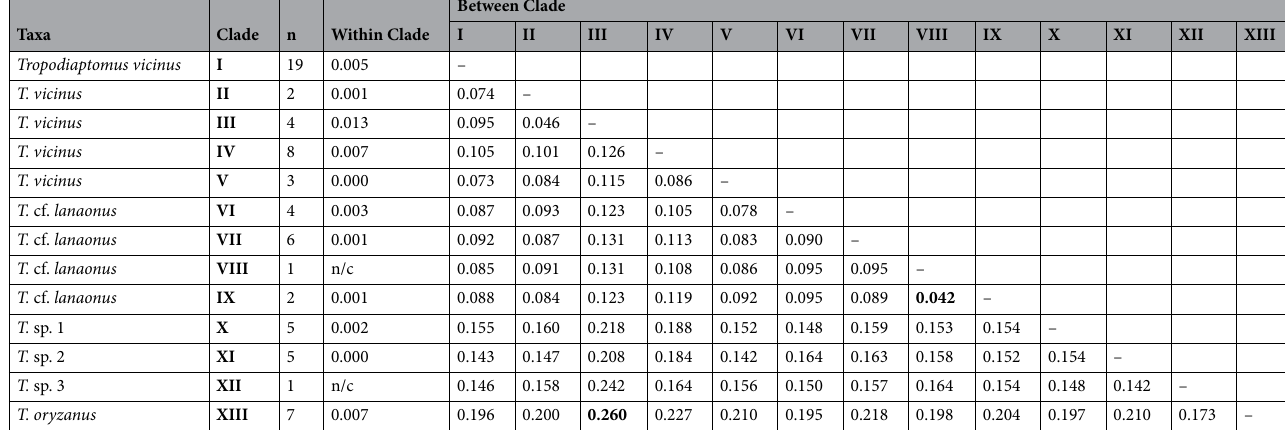
Table 3. Intra-clade and inter-clades genetic diversity, assessed by Kimura two-parameter distance based on the 12S rRNA-ITS2 dataset. Minimum and maximum values of genetic distance between clades are reported in bold. The presence of n/c in the results denotes cases in which it was not possible to estimate evolutionary